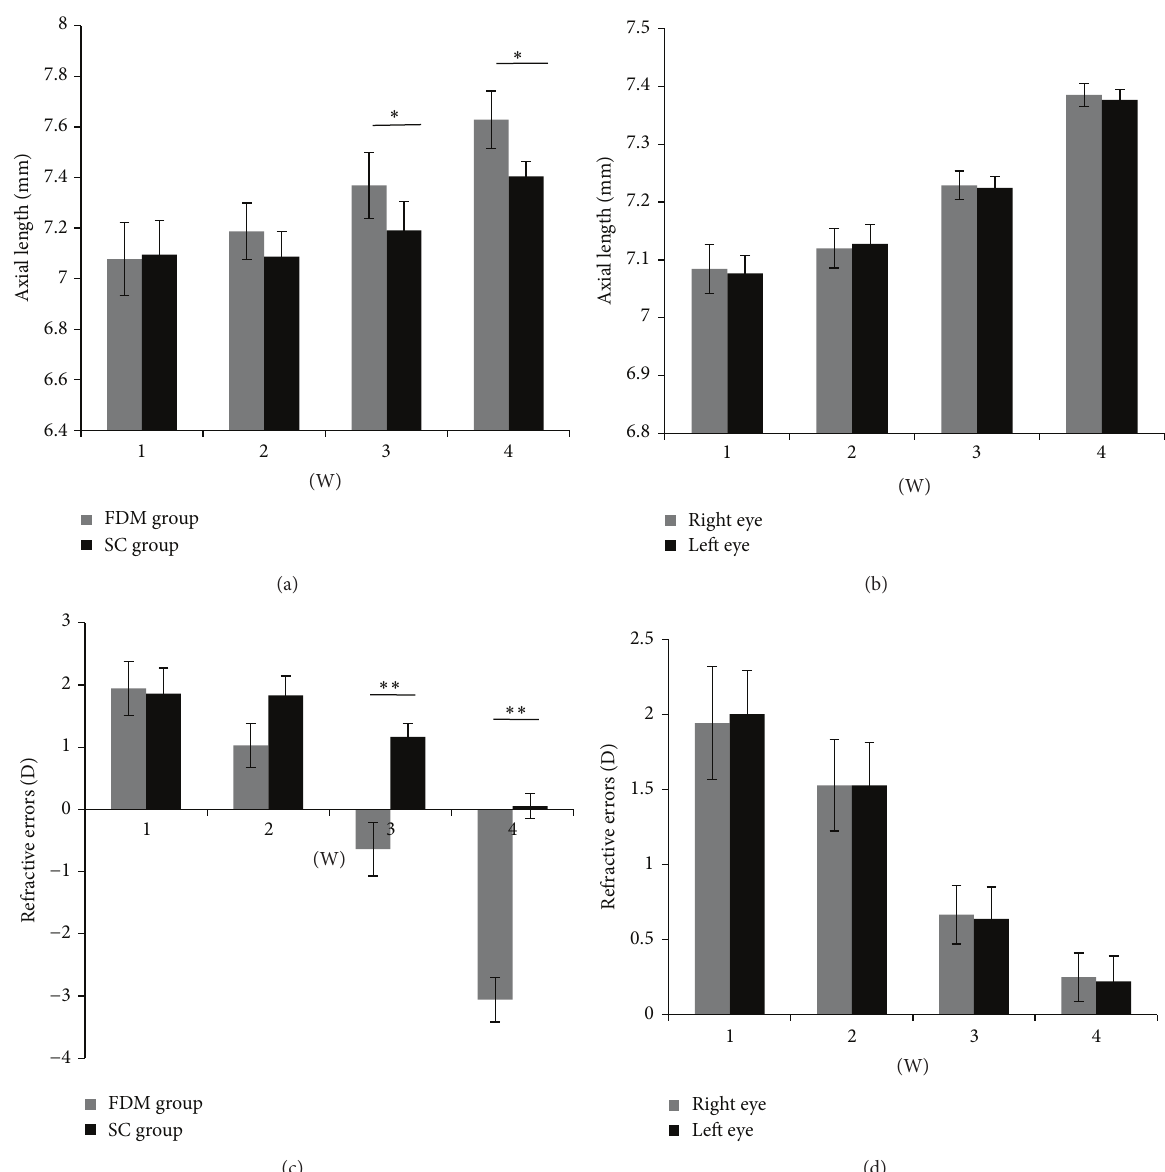
Figure 1: Axial length and refractive errors in FDM group, SC group, and NC group at 1 week, 2 weeks, 3 weeks, and 4 weeks. (a) Axial length compared FDM group with SC group. (b) Axial length compared right eye with left eye in NC group. (c) Refractive errors compared FDM group with SC group. (d) Refractive errors compared right eye with left eye in NC group. ∗ 𝑃 < 0.05 , ∗∗ 𝑃 < 0.01